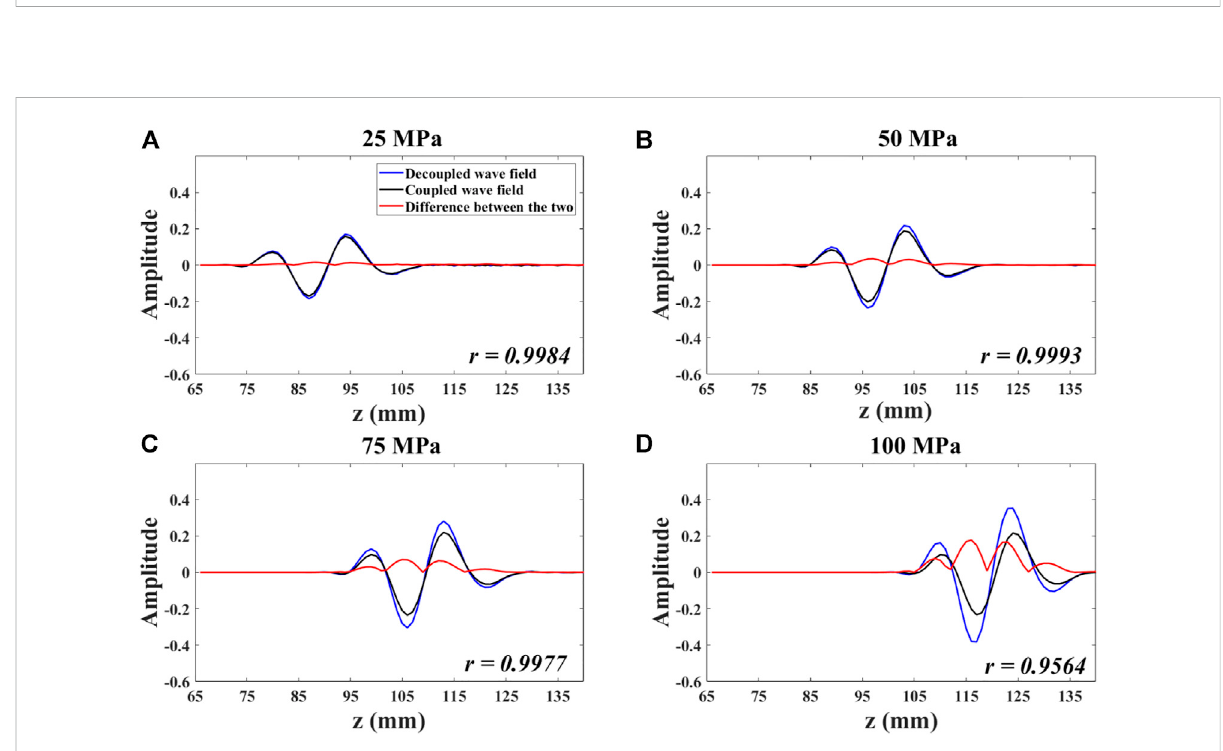
FIGURE 10 Part of Figure 9 ( (A) : 25 MPa; (B) : 50 MPa; (C) : 75 MPa; (D) : 100 MPa). (Red line represents the absolute value of the difference between the two wave fi elds; r represents the correlation between the two curves). Decoupled acoustoelastic simulation under the pure shear